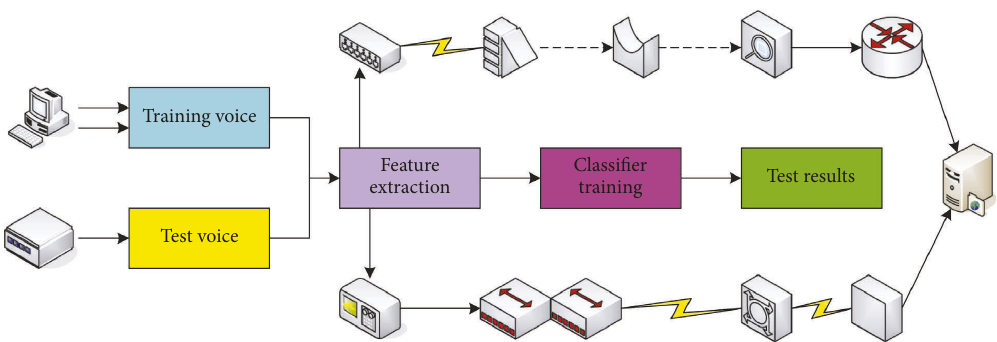
Figure 2: Synthetic speech detection framework diagram incorporating ASV